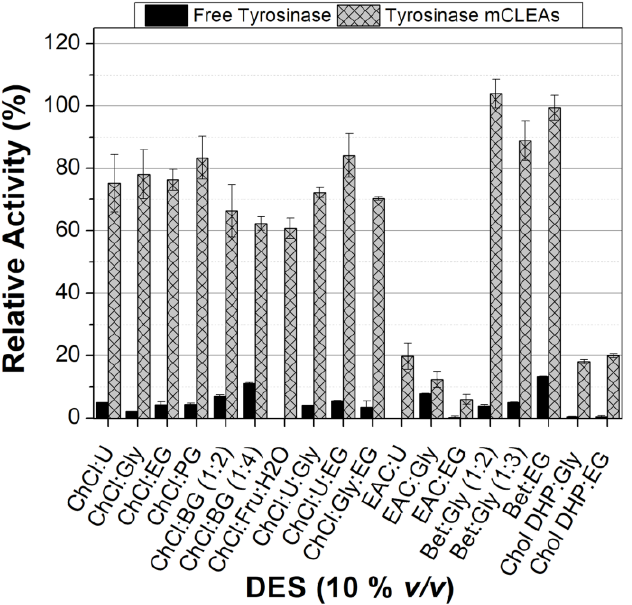
Figure 7. Relative activity of free tyrosinase and tyrosinase mCLEAs in 10% v / v of various DESs after pre-incubation at 30 °C for 24 h. 100% is defined as the residual activity of free tyrosinase and tyrosinase mCLEAs after pre-incubation at 30 °C for 24 h in DES-free solution.